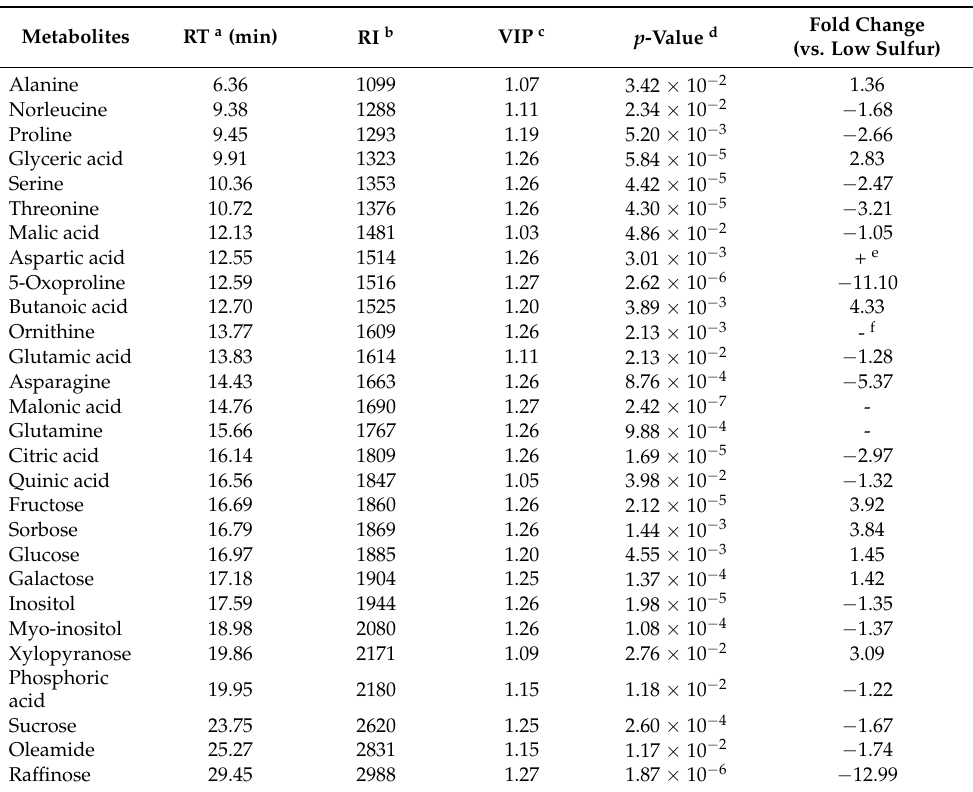
Figure 6. Partial least squares discriminant analysis (PLS-DA) score plots of lettuce metabolites using GC-MS and LC-MS. The qualification of the PLS-DA models was evaluated by the goodness of fit measure (R2X and R2Y) and predictive ability (Q2), and cross-validated with a permutation test (n = 200). Table 2. Identification of lettuce metabolites contributes to the sample groups’ separation based on the PLS-DA score plot for GC-MS analysis and their fold changes.